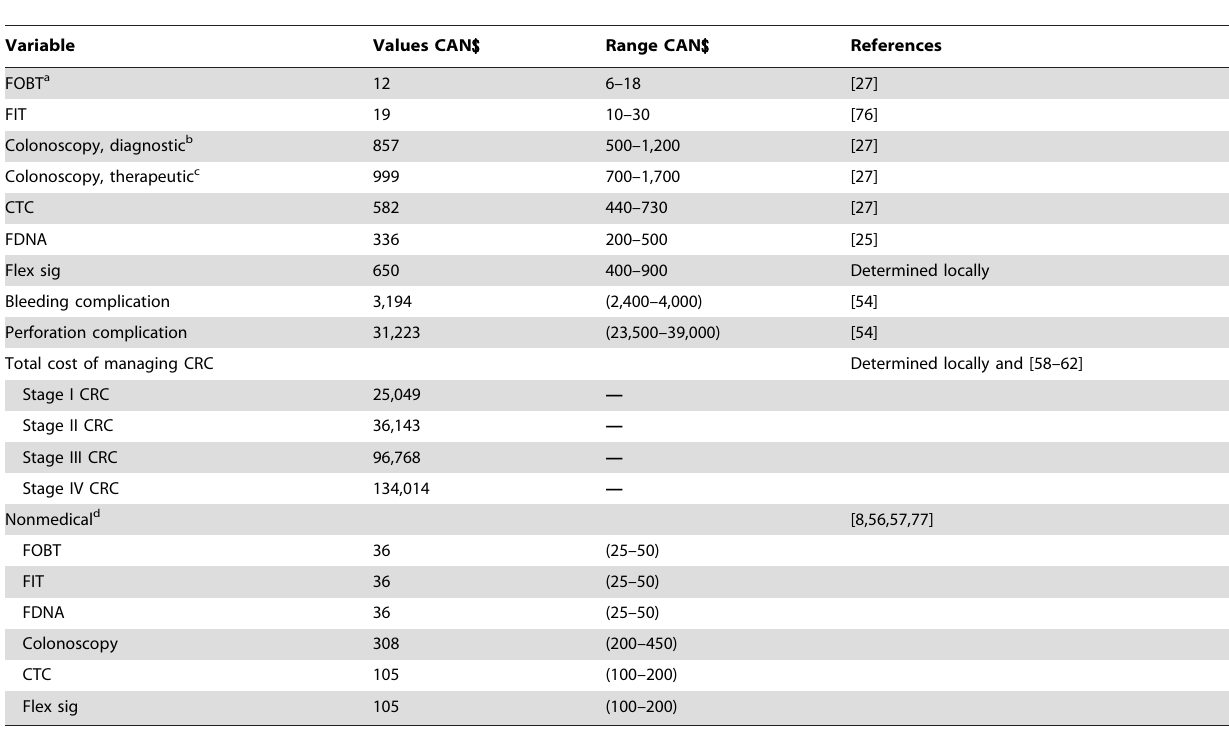
Table 3. Base case direct health care costs and nonmedical costs and ranges considered.